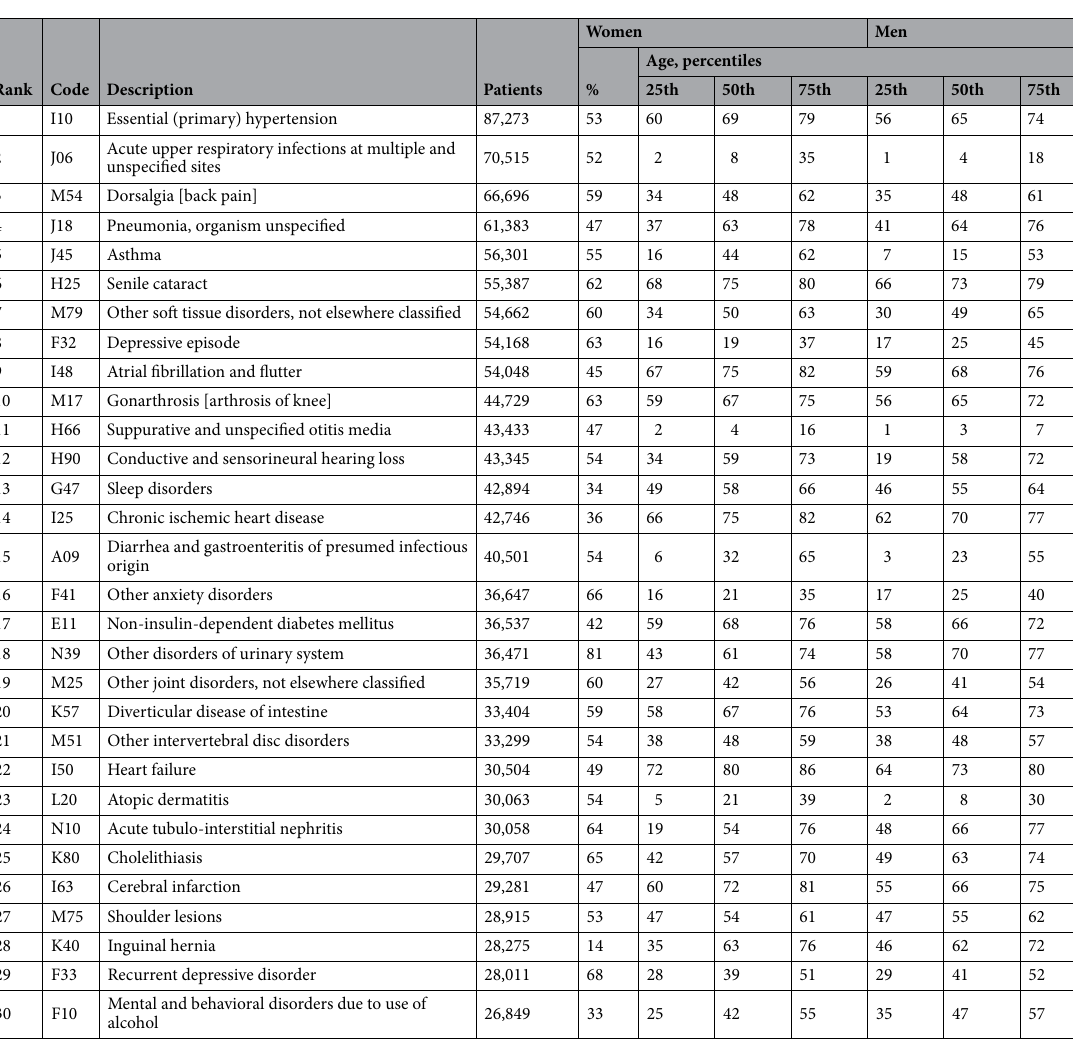
Table 1. The most common ICD-10 diagnoses, with sex- and age